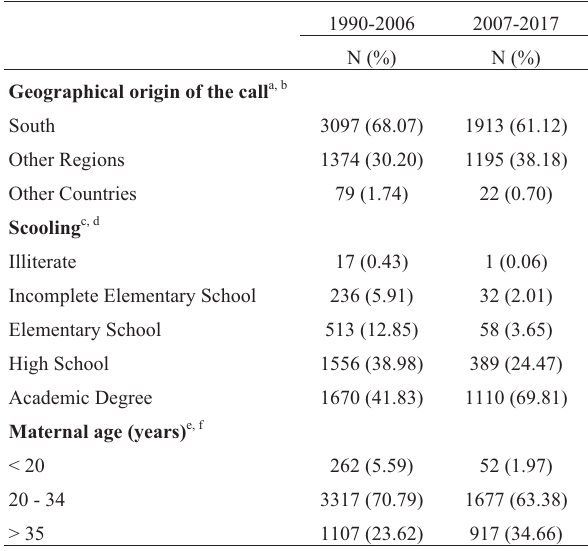
Table 2 - Demographic characteristics of the index